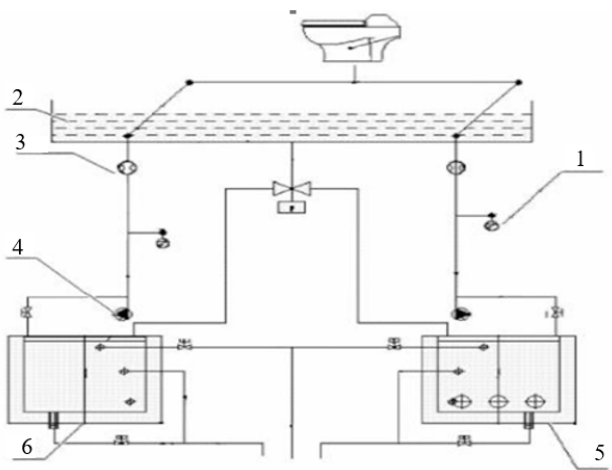
Figure 5. Schematic diagram of detection for a smart water closet. Note: 1—Pressure gauge; 2— Weight scale; 3—Flow meter; 4—Water pump; 5—Cold water tank; 6—Hot water tank.